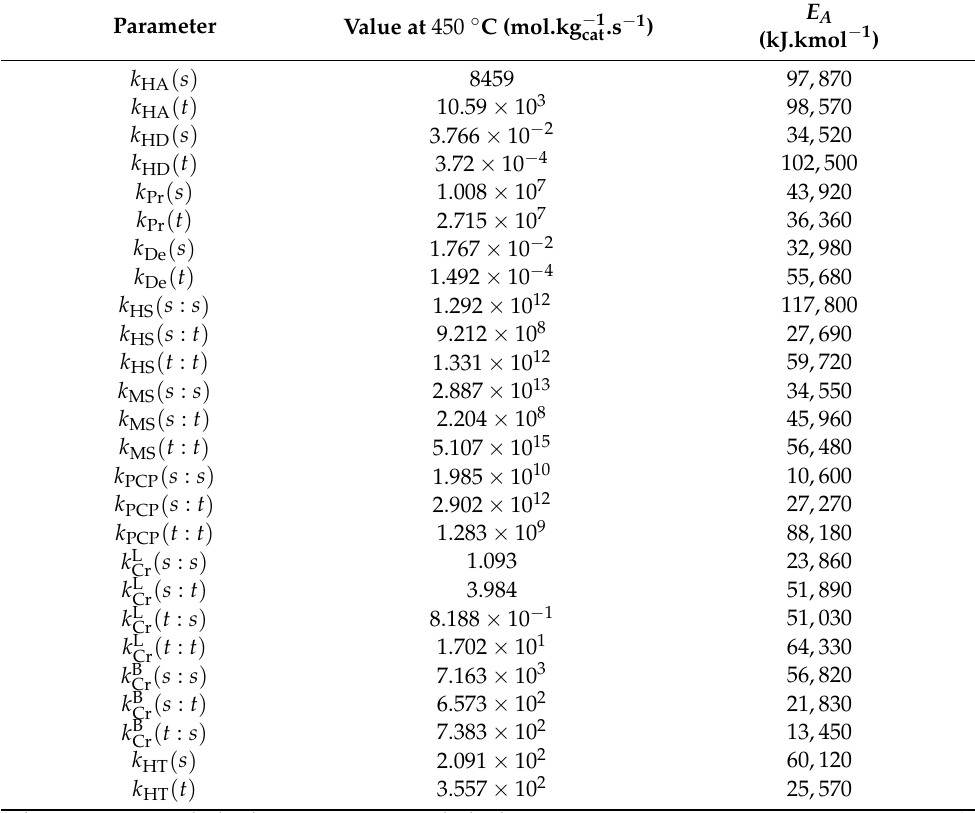
Table 5. Single-event rate kinetic parameters for cracking of paraffins over RE-Y catalyst by Feng et al.